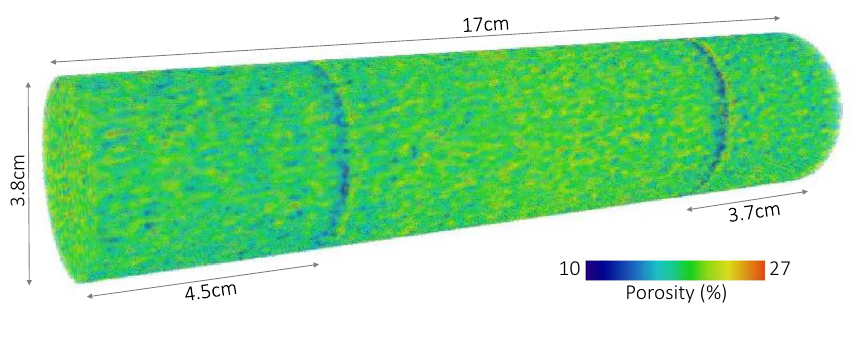
Figure 1. 3D porosity map of the core. The two low porosity bands are clearly